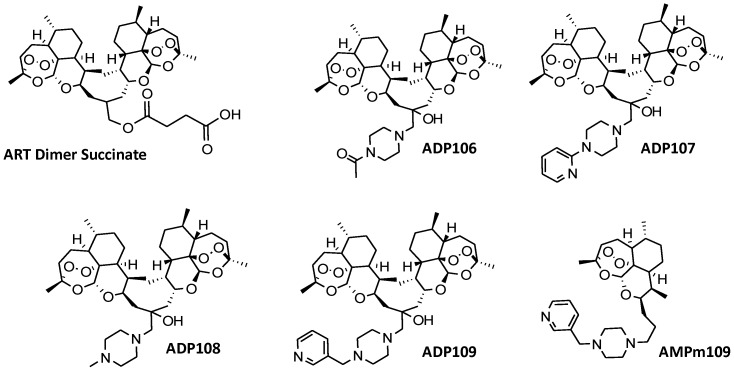
Structures of artemisinin dimer succinate, ADPs 106–109 and ADPm109 the monomer analogue of compound ADP109.